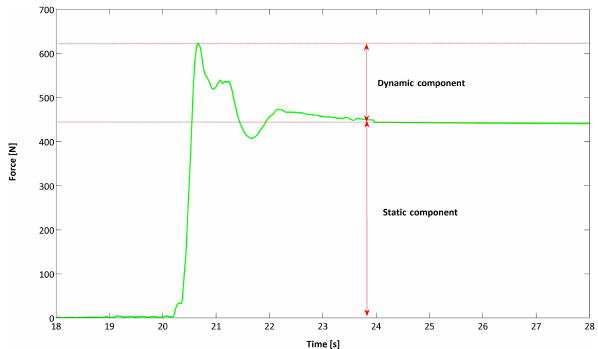
Figure 5. Total impact force measured at load cells vs. time; the static and the dynamic component are